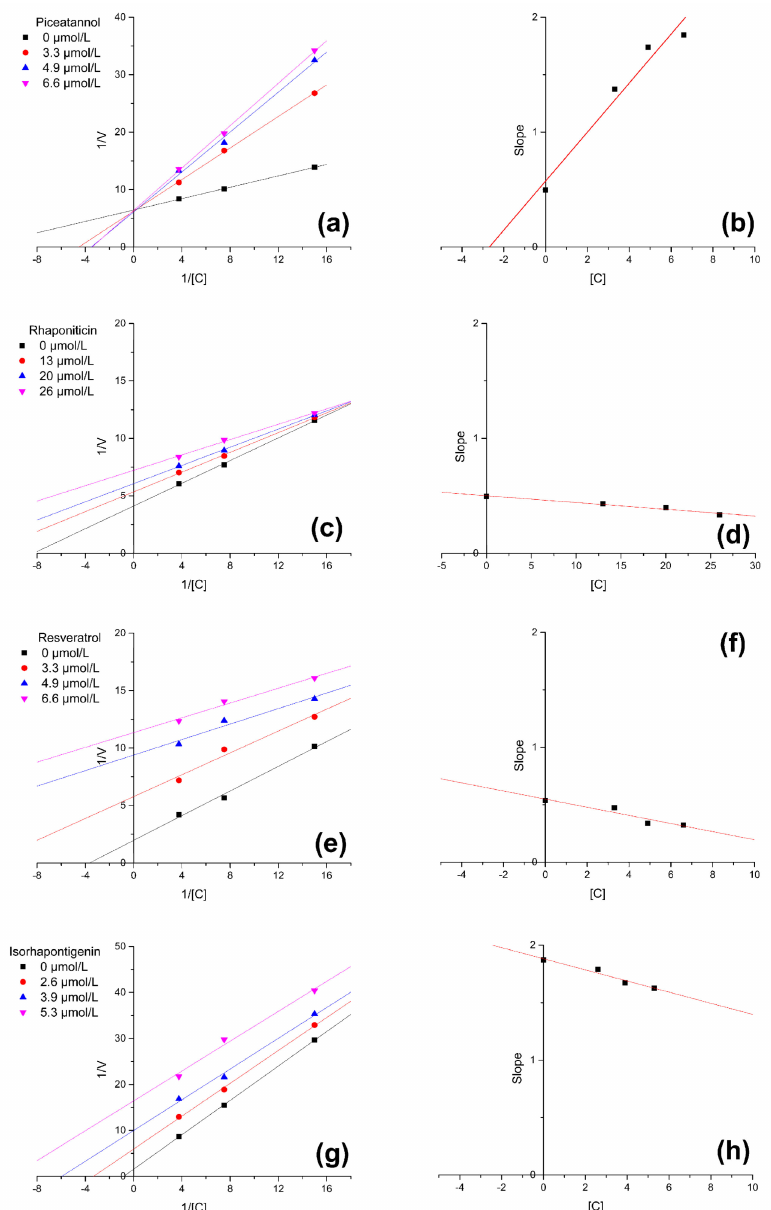
Figure 3. Lineweaver-Burk plots for inhibition of xanthine oxidase (XO) by ( a ) piceatannol, ( c ) rhaponiticin, ( e ) resveratrol, and ( g ) isorhapontigenin. Secondary plots of slopes against concentrations of ( b ) piceatannol, ( d ) rhaponiticin, ( f ) resveratrol, and ( h ) isorhapontigenin to calculate K i